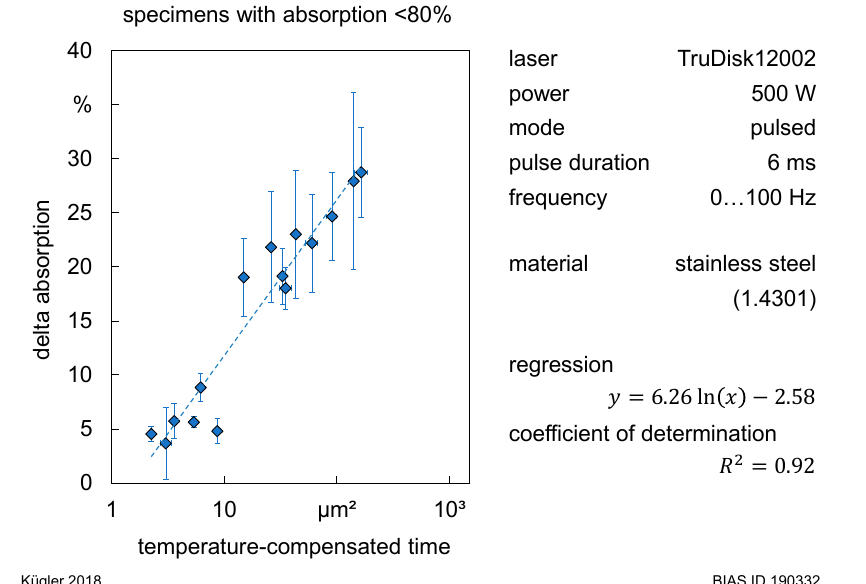
Figure 12. Absorption changes due to laser beam heating.